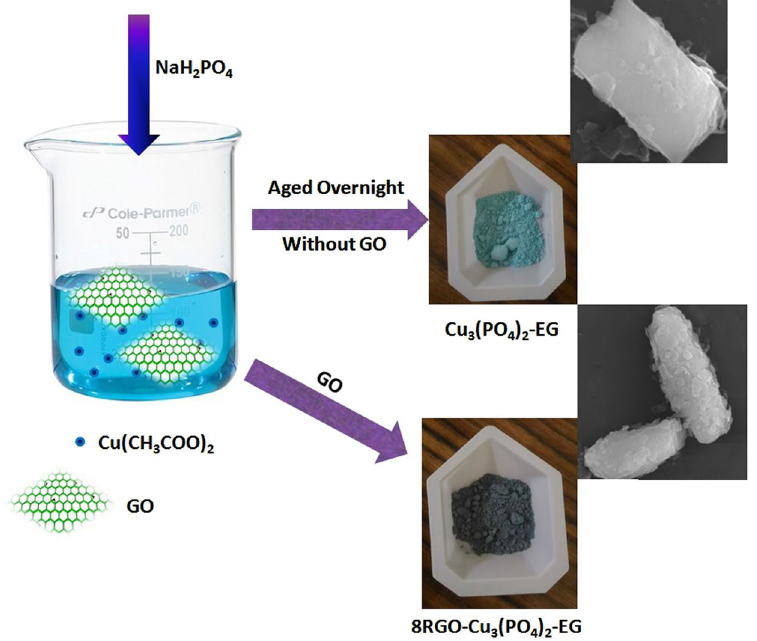
Figure 17. Pictorial representation of Cu 3 (PO 4 ) 2 -EG